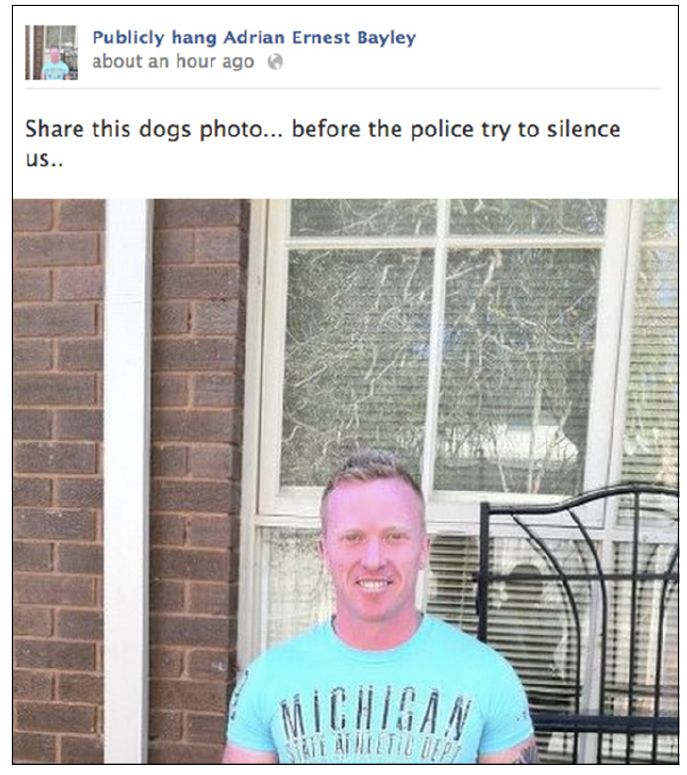
Figure 2: Photo of Bayley recovered from the accused’s Facebook profile and posted on social media within hours or his arrest